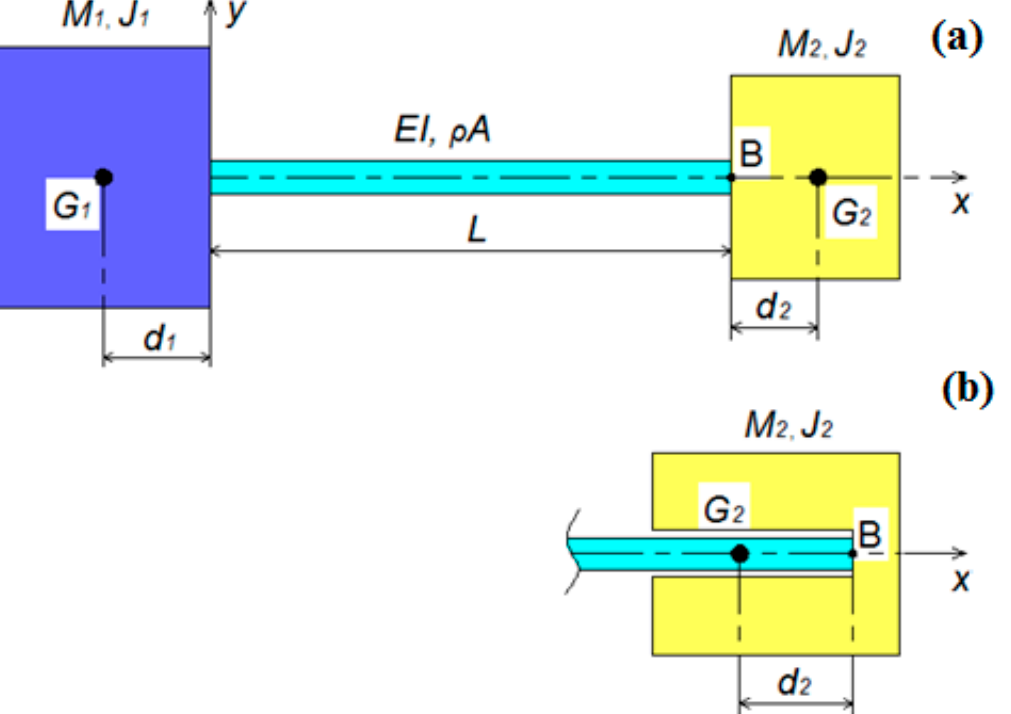
Figure 1. ( a ) The free–free beam with unequal end masses; ( b ) an alternative attachment of the end mass that has its gravity center point at ξ <